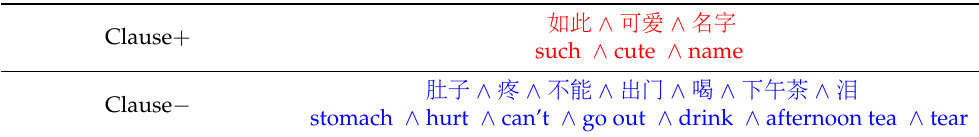
Table 11. Literals learning results in Sentiment